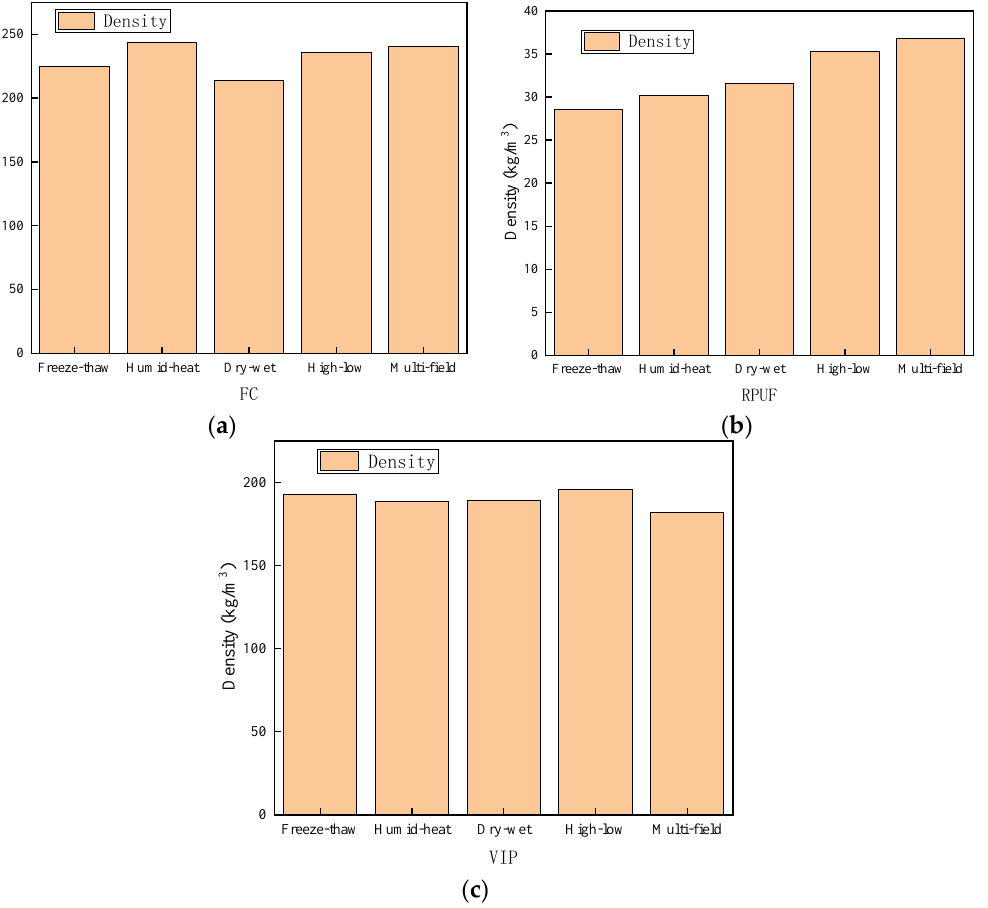
Figure 8. Changes in density of materials after the 112 days of cycling: ( a ) FC, ( b ) RPUF, and ( c ) VIP.